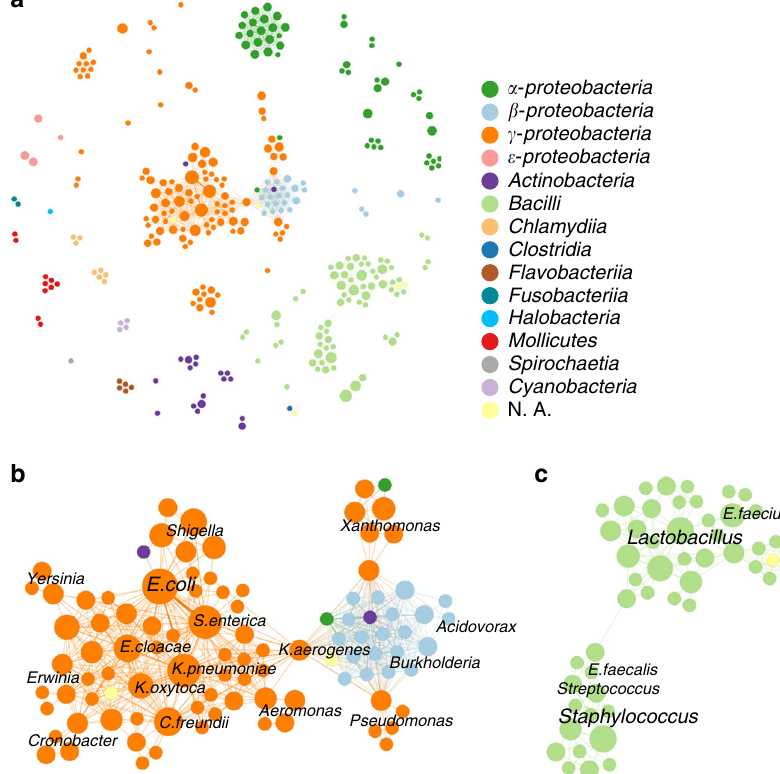
Fig. 7 HGT pathways in bacteria drawn by PTUs. a A network showing possible plasmid-mediated pathways for genetic exchanges between different species. Each node in the network represents a bacterial species. The size of the node is proportional to the number of PTUs identi fi ed in that species, and the color code corresponds to its cognate taxonomical class or phylum ( Cyanobacteria ). b The exchange community formed by species from γ and β - proteobacteria . As in the panel above, the size and color of the nodes represent the number of PTUs and the taxonomic class of the species considered, respectively. c The exchange community formed by the orders Bacillales and Lactobacillales